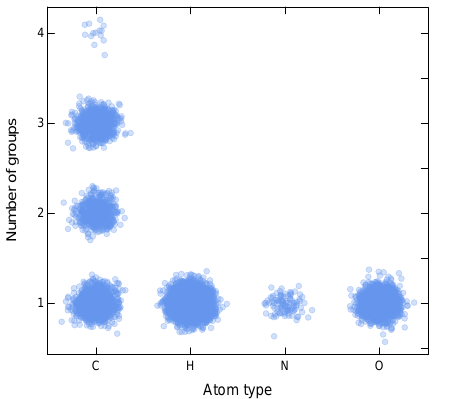
Figure 5. Logarithm of the pure-component saturation concen- tration (log 10 C 0 ) and mean carbon oxidation state of each com- pound (OS C ) measured by Rogge et al. (1993) and Rogge et al. (1998) for biomass burning and vehicle emissions sources (green and blue lines), as well as of each molecule constitut- ing the MCMv3.2 gas-phase oxidation mechanism of α -pinene and 1,3,5-trimethylbenzene. The lines in the plot denote isolines (0 , 0 . 1 ,..., 0 . 9) of the maximum density estimate for the different compound sets. The black dots indicate the position of α -pinene and 1,3,5-trimethylbenzene. The area of the plot is divided into volatil- ity regions according to the classification of Donahue et al.